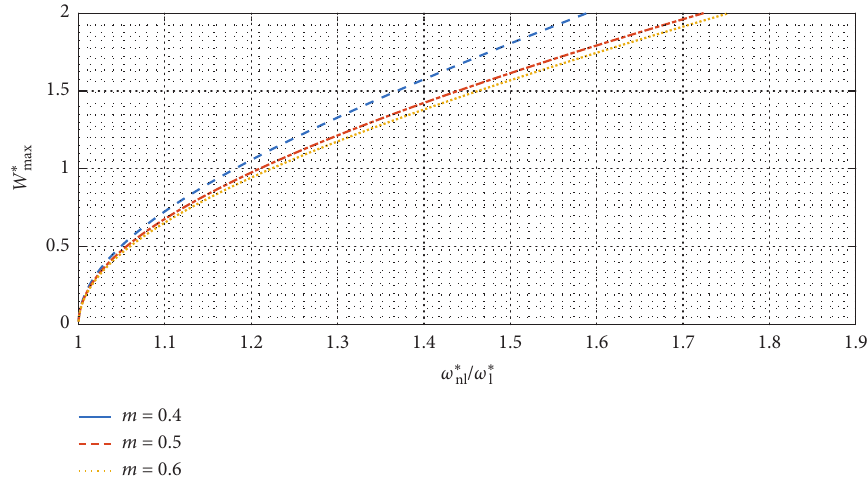
Figure 4: Backbone curves of beam (a) in the vicinity of the first mode for various values of m .